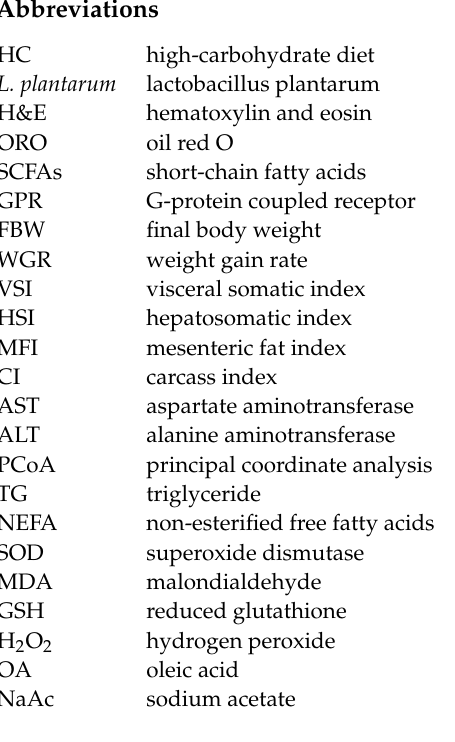
diets; Table S2: Primers used for RT-qPCR expression analysis; Table S3: The antibodies information for immunofluorescence and Western blotting assay; Figure S1: L. plantarum MR1 inhibited lipid accumulation-induced liver inflammation in Nile tilapia; Figure S2: Uridine suppressed the OA- induced inflammation in the primary hepatocytes of Nile